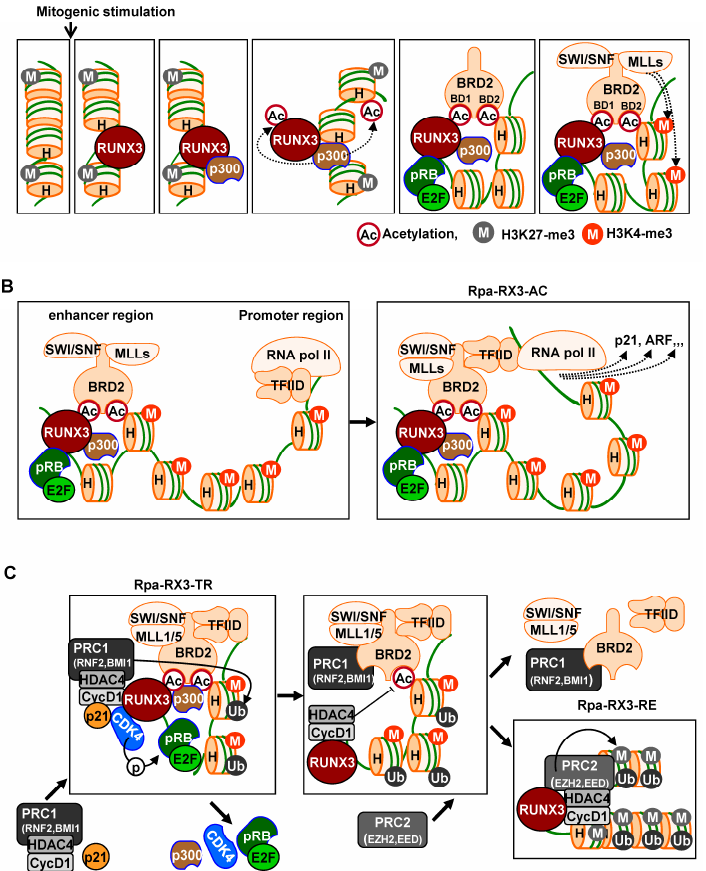
Figure 2. Sequential molecular events for R-point decisions. ( A ) In response to mitogenic stimulation, RUNX3 opens target loci. Upon mitogenic stimulation, RUNX3 binds to the enhancer regions of target loci within inactive chromatin, as indicated by H3K27-me3. pRB-E2F1 and p300 associate with RUNX3. p300 acetylates RUNX3 and histones. BRD2 binds to acetylated RUNX3 through its